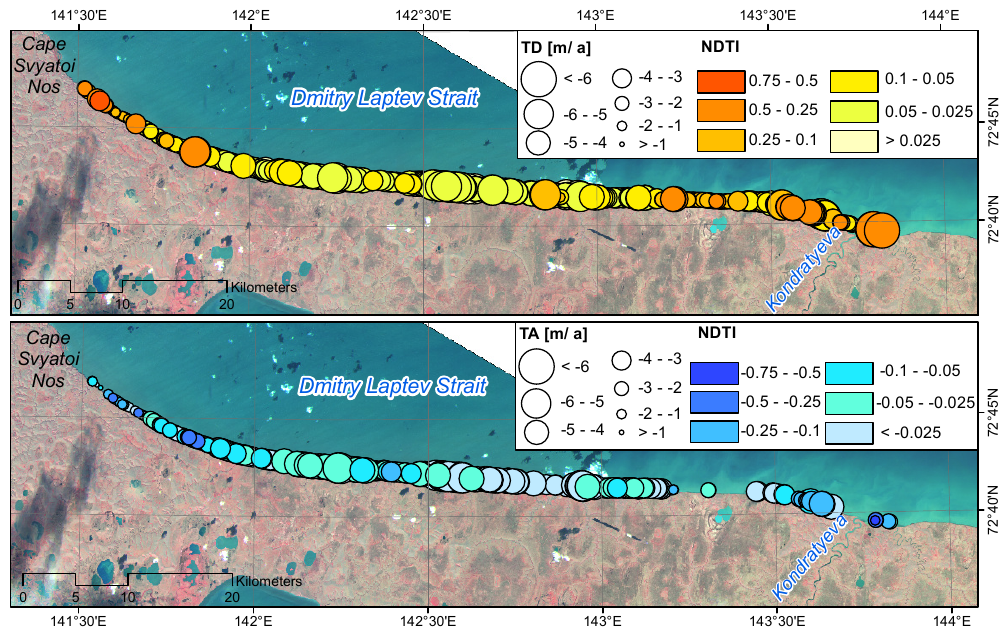
Fig. 9. Thematic map of coastal thermo-erosion transect data along the studied coastline of Oyogos Yar (Yana-Indigirka lowland west of Cape Svyatoi Nos; Dmitry Laptev Strait). The upper map segment illustrates colour coded positive NDTI values associated with prevailing thermo-denudation (TD), the lower map illustrates colour coded negative NDTI values associated with prevailing thermo-abrasion (TA). The symbol size is equivalent to erosion